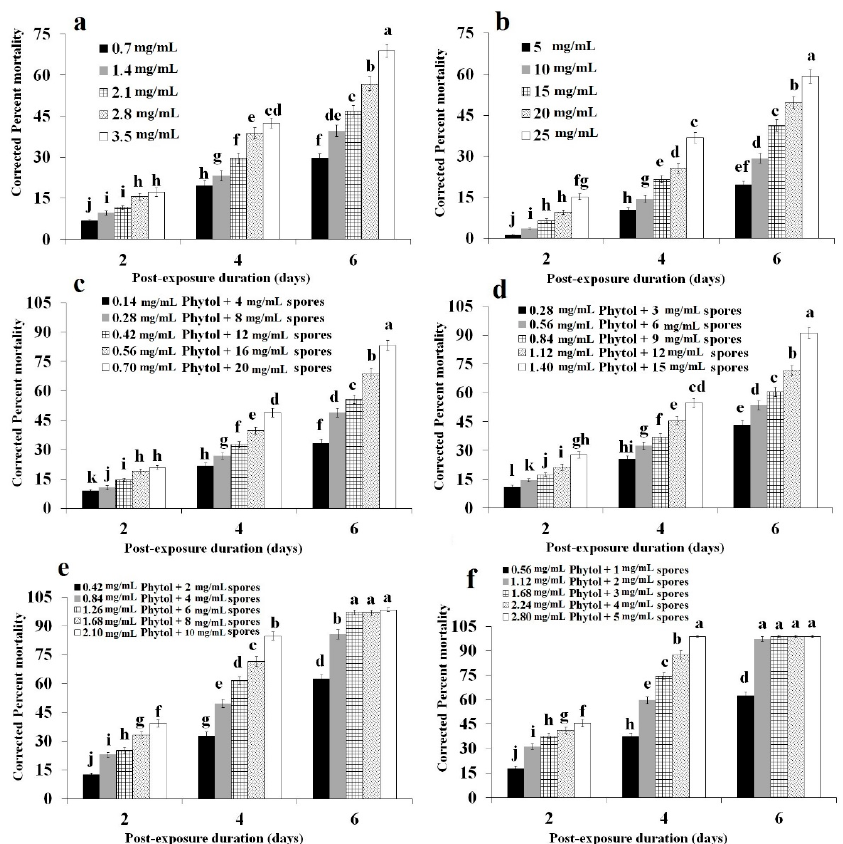
Figure 2. Corrected percent cumulative concentration-mortality response of Oligonychus